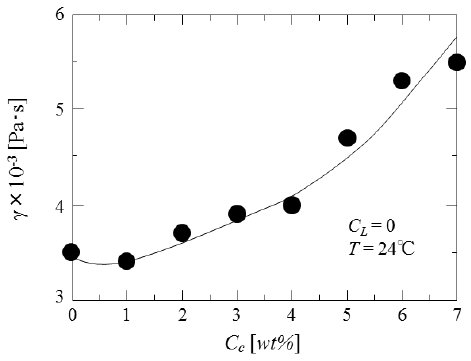
Figure 6. Dependence of interfacial tension on curdlan concentration.